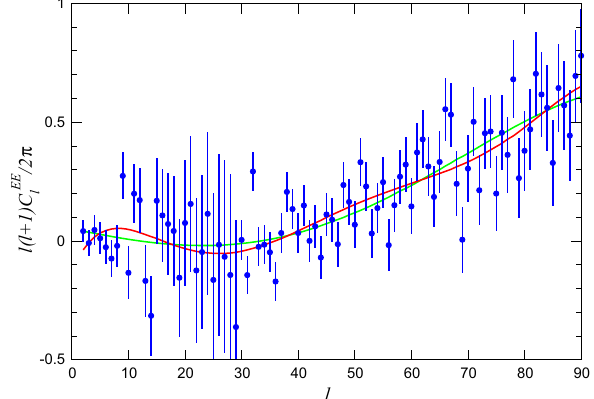
Fig. 2 Same as Fig. 1 but in this case the lines are the derived EE CMB power spectrum based upon the fits to the TT power spectrum shown in Fig.